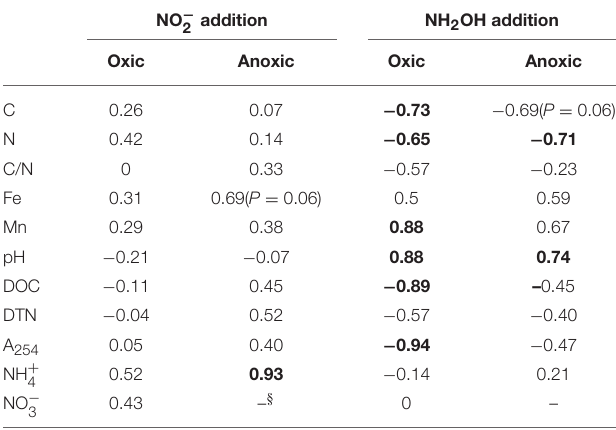
TABLE 4 | Spearman’s correlation coefficients between soil N 2 O emissions and soil properties after 7h of